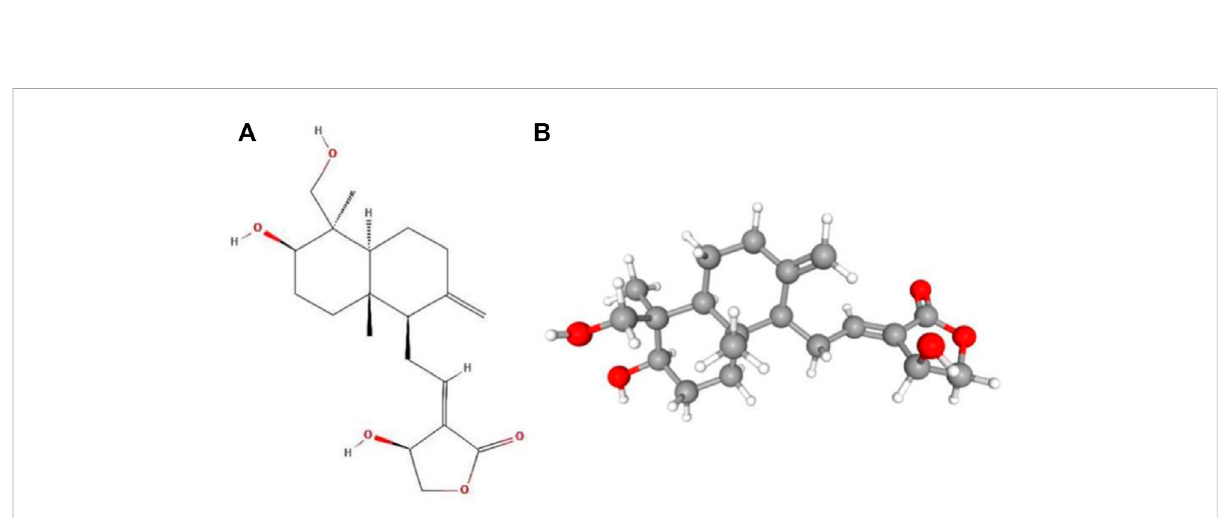
FIGURE 2 Molecular structure of andrographolide. (A) Two-dimensional structure of andrographolide. (B) Three-dimensional structure of